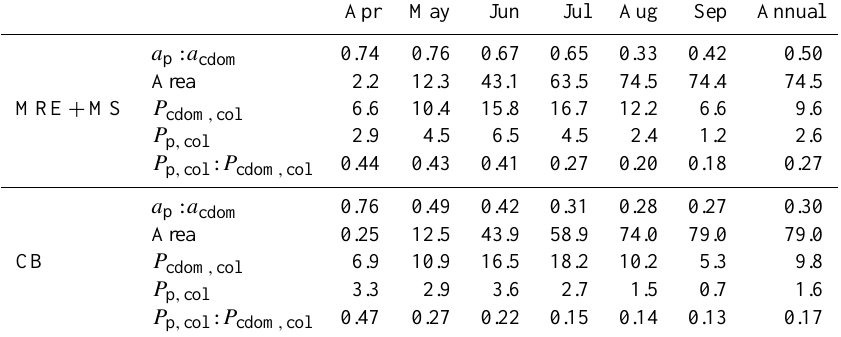
Table 5. P cdom , col , P p , col (µmolm − 2 d − 1 ) , and P p , col : P cdom , col based on ocean color data from remote sensing. Also included